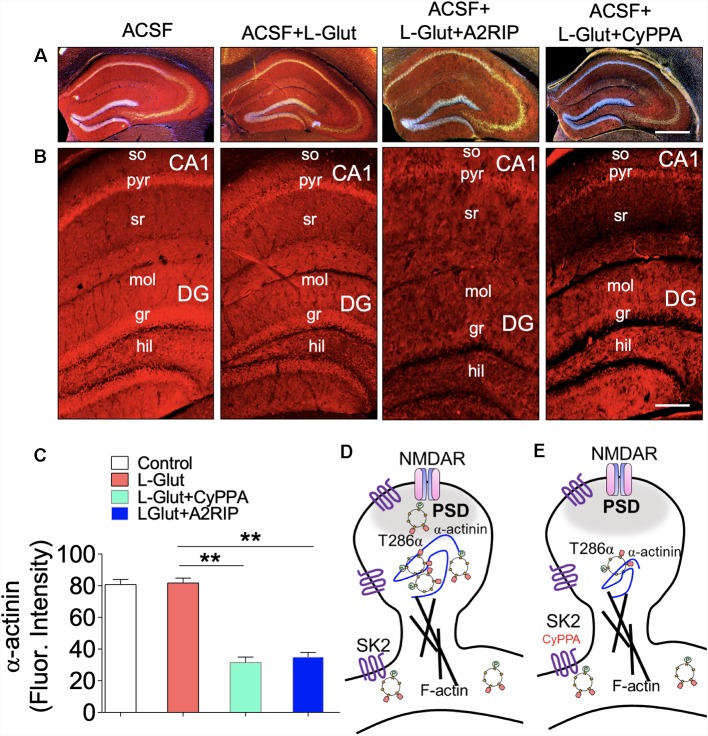
SK channel potentiation impacts hippocampal α-actinin expression. (A–B) Fluorescence images illustrating α-actinin expression in the hippocampus (so, stratum oriens; pyr, pyramidal layer; sr, stratum radiatum; mol, molecular layer; gr, granule cell layer, and hil, hilus). Scale bar = 0.4 mm (A), 100 μm (B). (C) Bar graph representation of α-actinin fluorescence intensity in the hippocampus (One-Way ANOVA). Schematic illustration of SK2 modulation of CaMKII spine anchorage: (D) synaptic pCaMKII is structurally linked with to the GluN2B sub-unit of NMDAR and is anchored to the dendritic spine cytoskeleton (F-actin) by α-actinin. In NMDAR-mediated synaptic potentiation, synaptic accumulation of pCaMKIIα/β is facilitated by α-actinin. (E) SK channel potentiation induced a loss CaMKII and α-actinin expression (C; **p < 0.01).